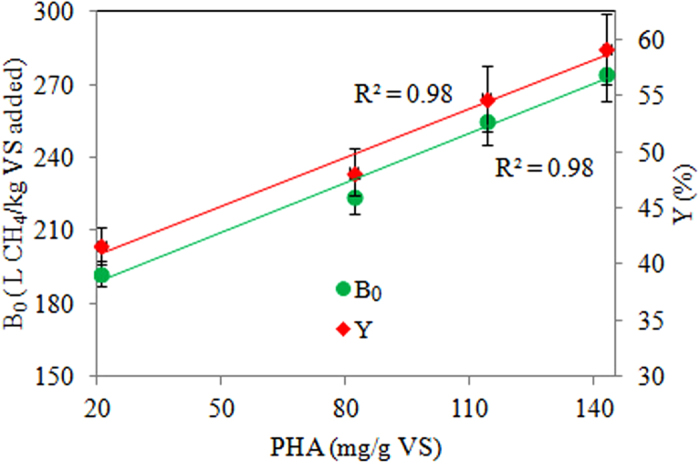
Relationships between PHA levels and B0, and PHA levels and Y.